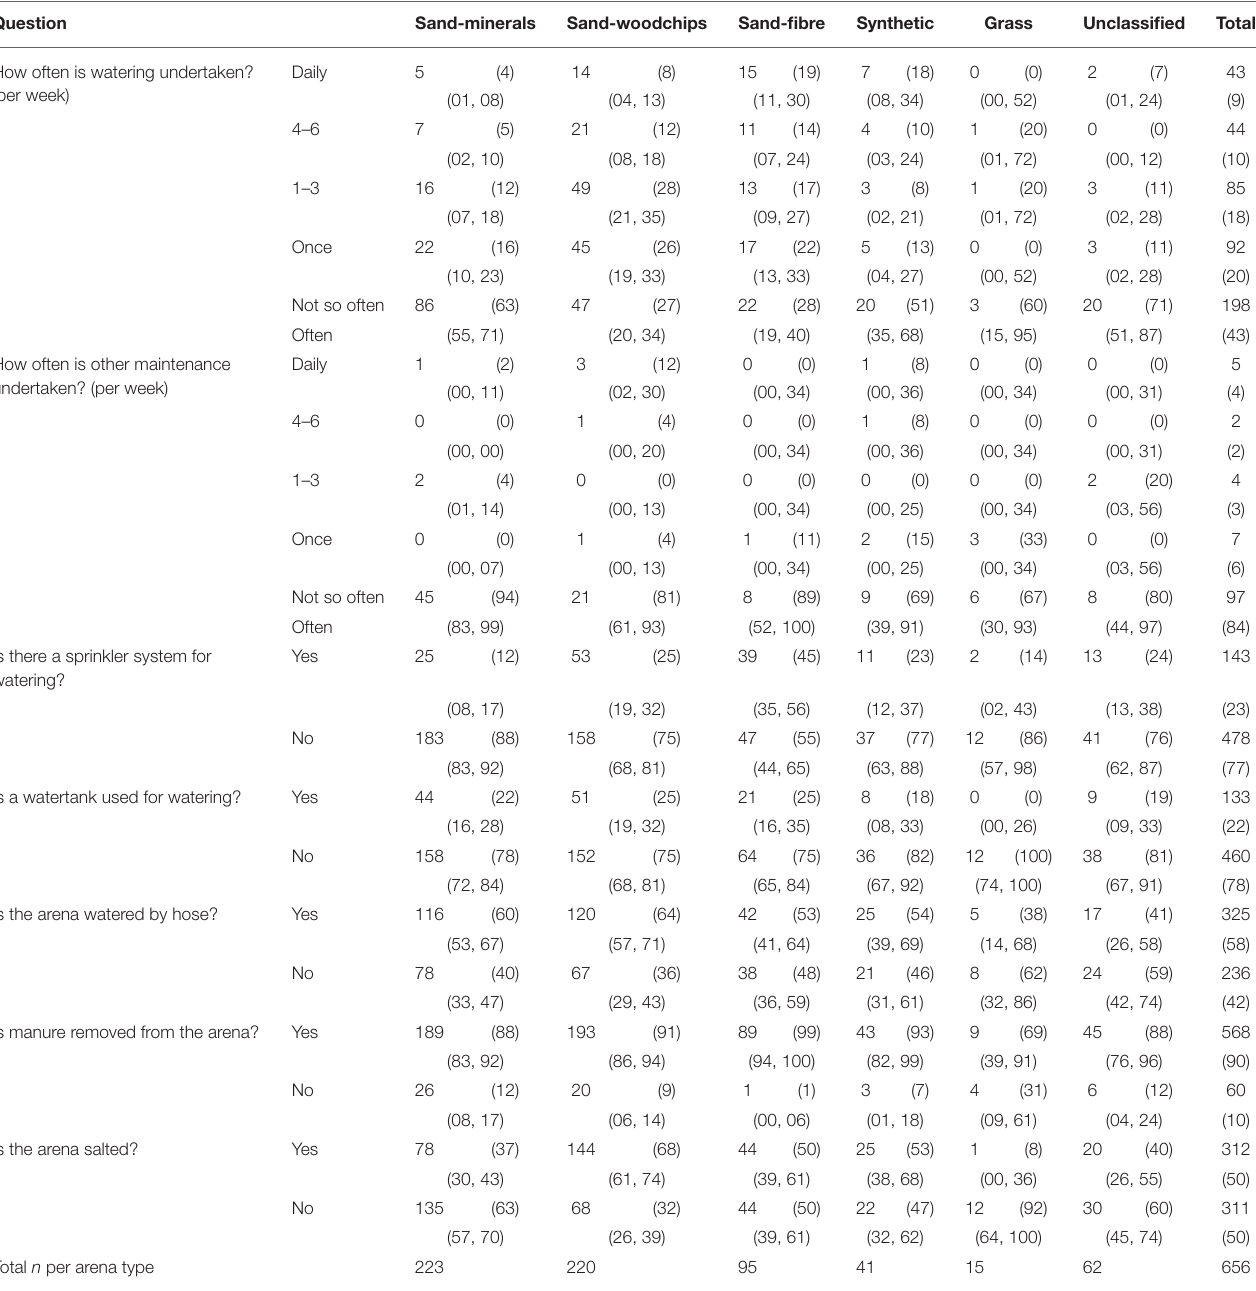
TABLE 5 | Frequency distributions of means used to maintain the